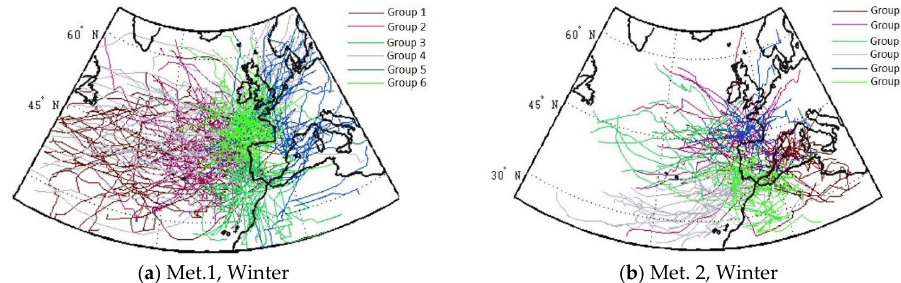
Figure 6. Groups of trajectories based on the K-means clustering with K equal 6 for Winter months: